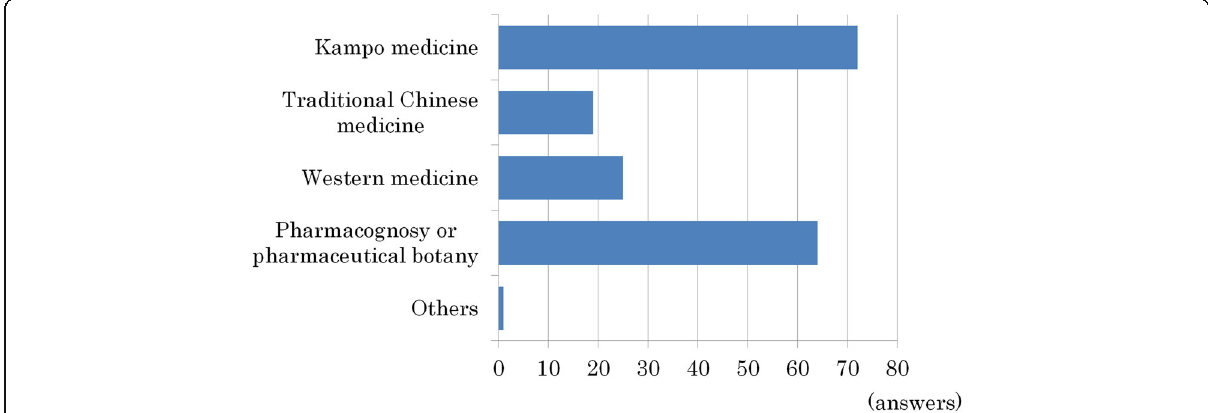
Fig. 2 The concept of Kampo related education. A total of 72 schools (97%) were based on Japanese traditional medicine; on the other hand, 19 schools (26%) were based on TCM (traditional Chinese medicine), 25 schools (34%) on Western EBM (evidence-based medicine), 64 schools (86%) on pharmacognosy and/or pharmaceutical botany, and only 1 school was based on the general history of medicine (multiple responses were